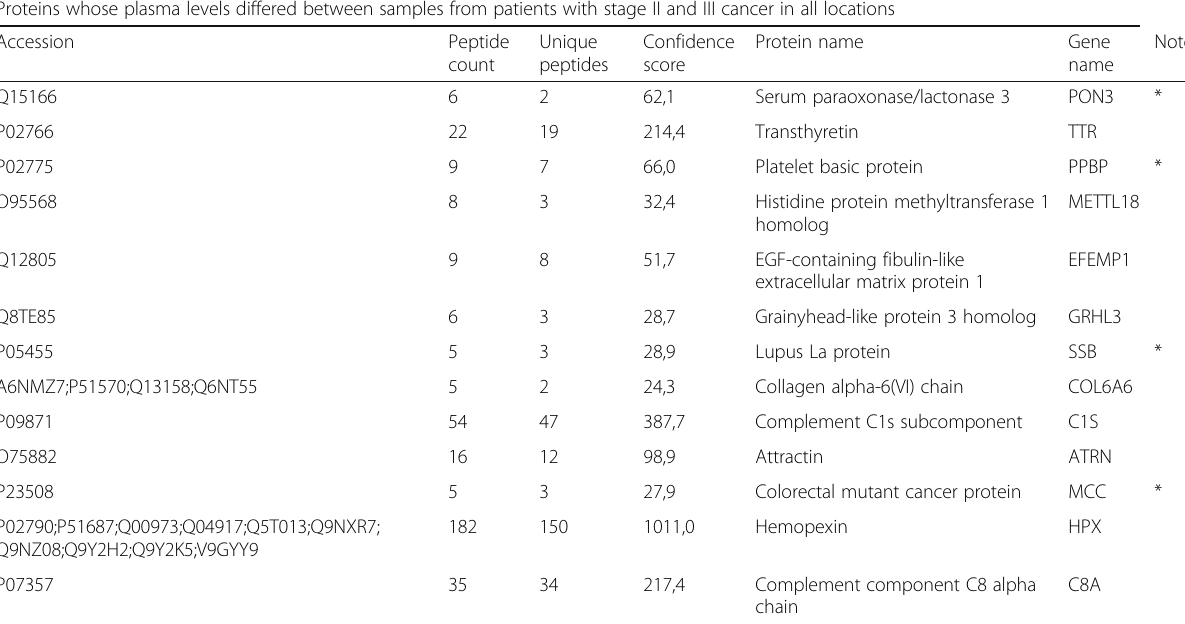
Table 2 The Venn diagram proteins whose levels differed during CRC progression in all locations Proteins whose plasma levels differed between samples from patients with stage II and III cancer in all locations Accession Peptide Unique count